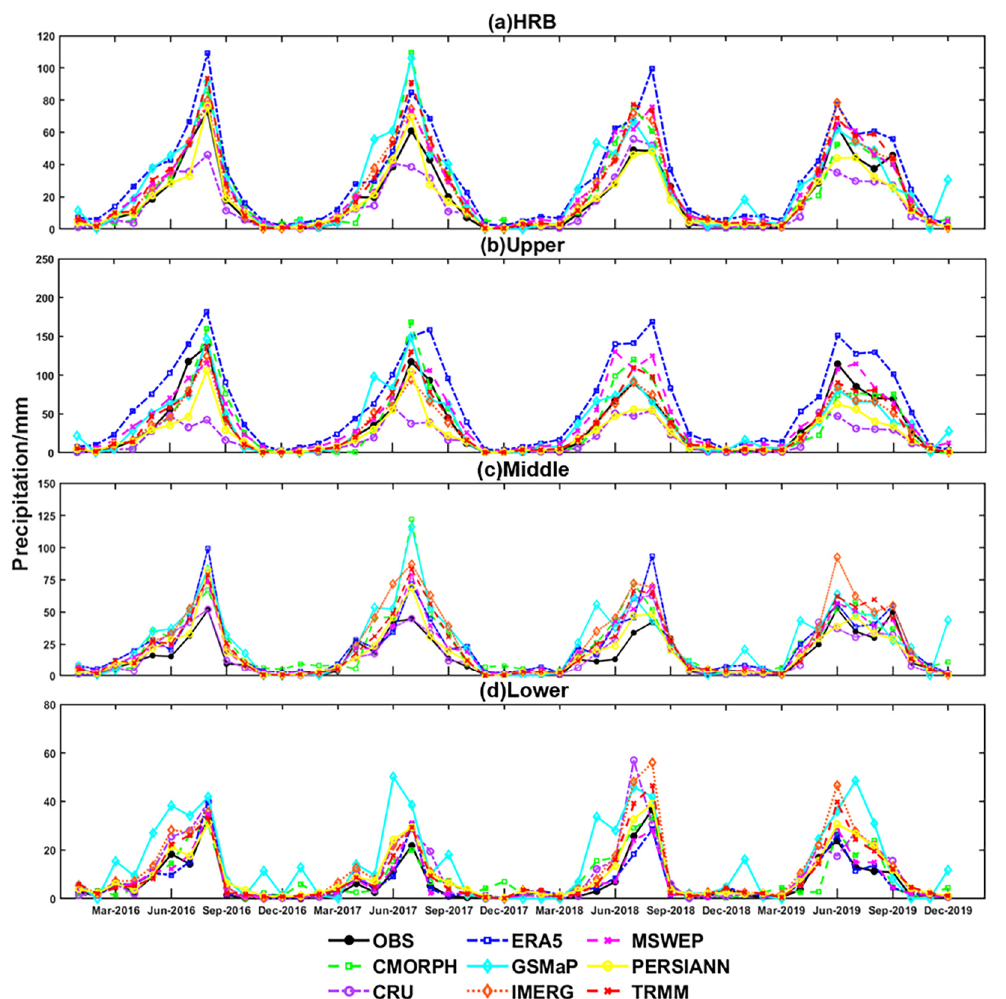
Figure 9. Time series diagram of monthly mean precipitation of estimates from each product and observations at stations over the ( a ) entire HRB and ( b ) upper, ( c ) middle and ( d ) lower reach area during 2016–2019.